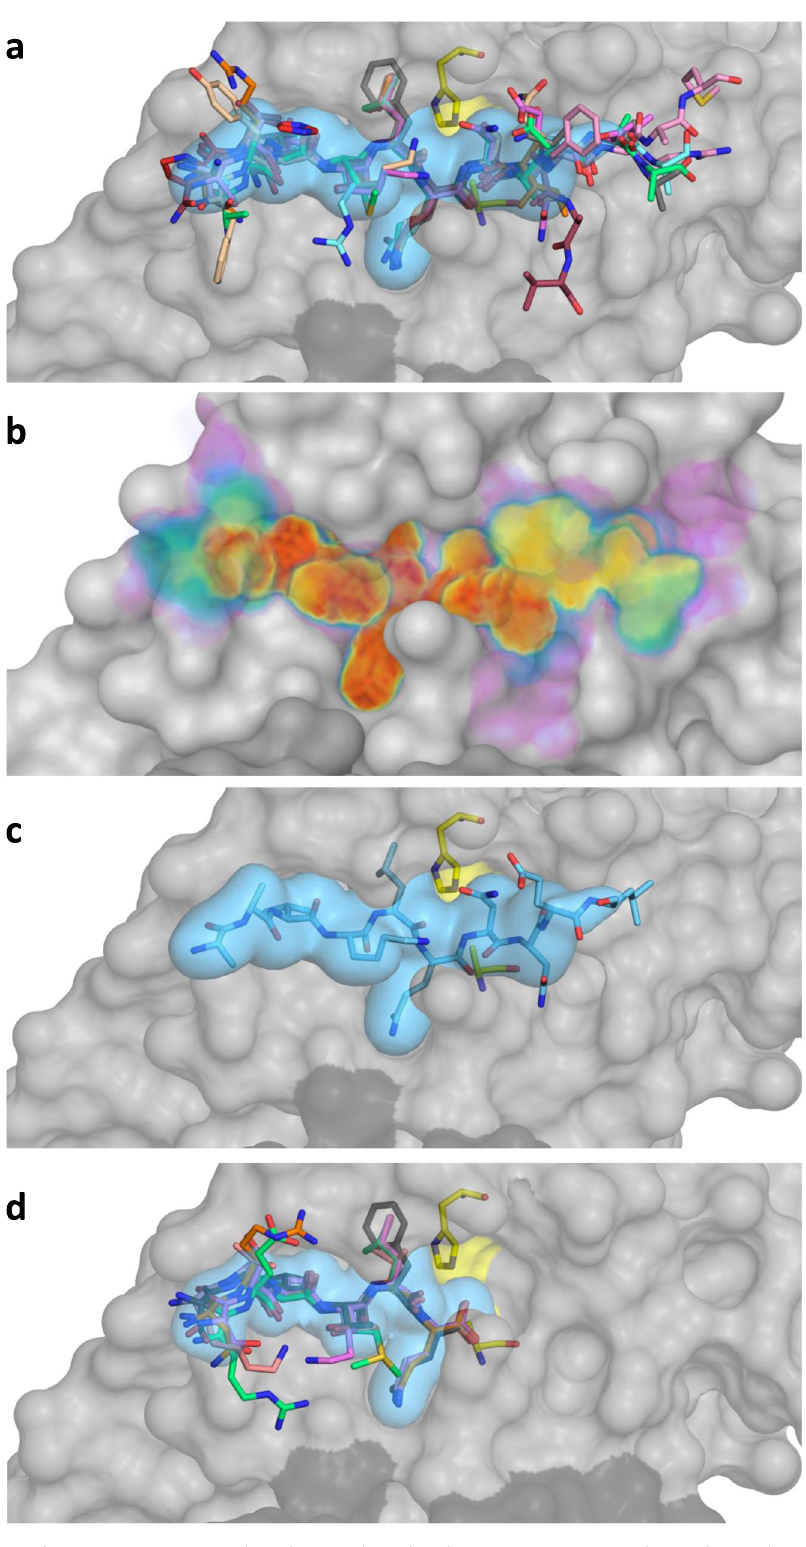
Fig. 4 The substrate envelope of SARS-CoV-2 M pro . a The substrates bound at the M pro active site are depicted as sticks in the superimposed cocrystal structures, where the protease is in gray surface representation. The consensus volume occupied by the substrates de fi ne the substrate envelope, shown as the blue volume and is the intersection of any four of the nine substrates. b The gradient substrate envelope colored according to the number of substrates that occupy the consensus volume. Purple to red gradient indicates less to more consensus. c Substrate nsp8-nsp9 in the substrate envelope. d Superposition of cocrystal structures with cleaved N-terminal product complexes, de fi ning the product envelope (blue volume).